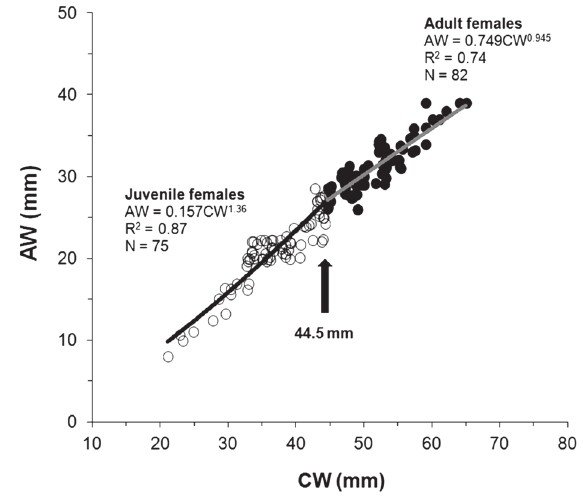
Figure 5. Ucides cordatus (Linnaeus, 1763). Scatter plot of the AWxCW relationship, based on female crabs captured monthly in the mangroves of the Joanes River, Lauro de Freitas Municipality (Bahia State, Brazil) between September 2011 and August 2012. The arrow indicates the size at morphological maturity, AW is the width of the 5 th abdominal somite, CW is the carapace width, N is the number of individuals, and R 2 is the coefficient of